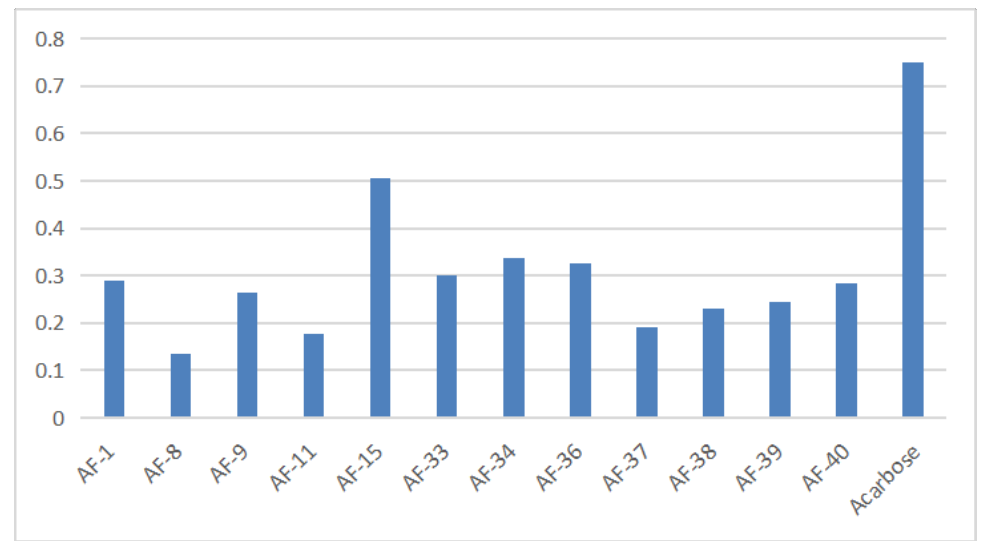
Figure 5. The result of A. tenuissimum flower flavonoids α− glucosidase inhibitory